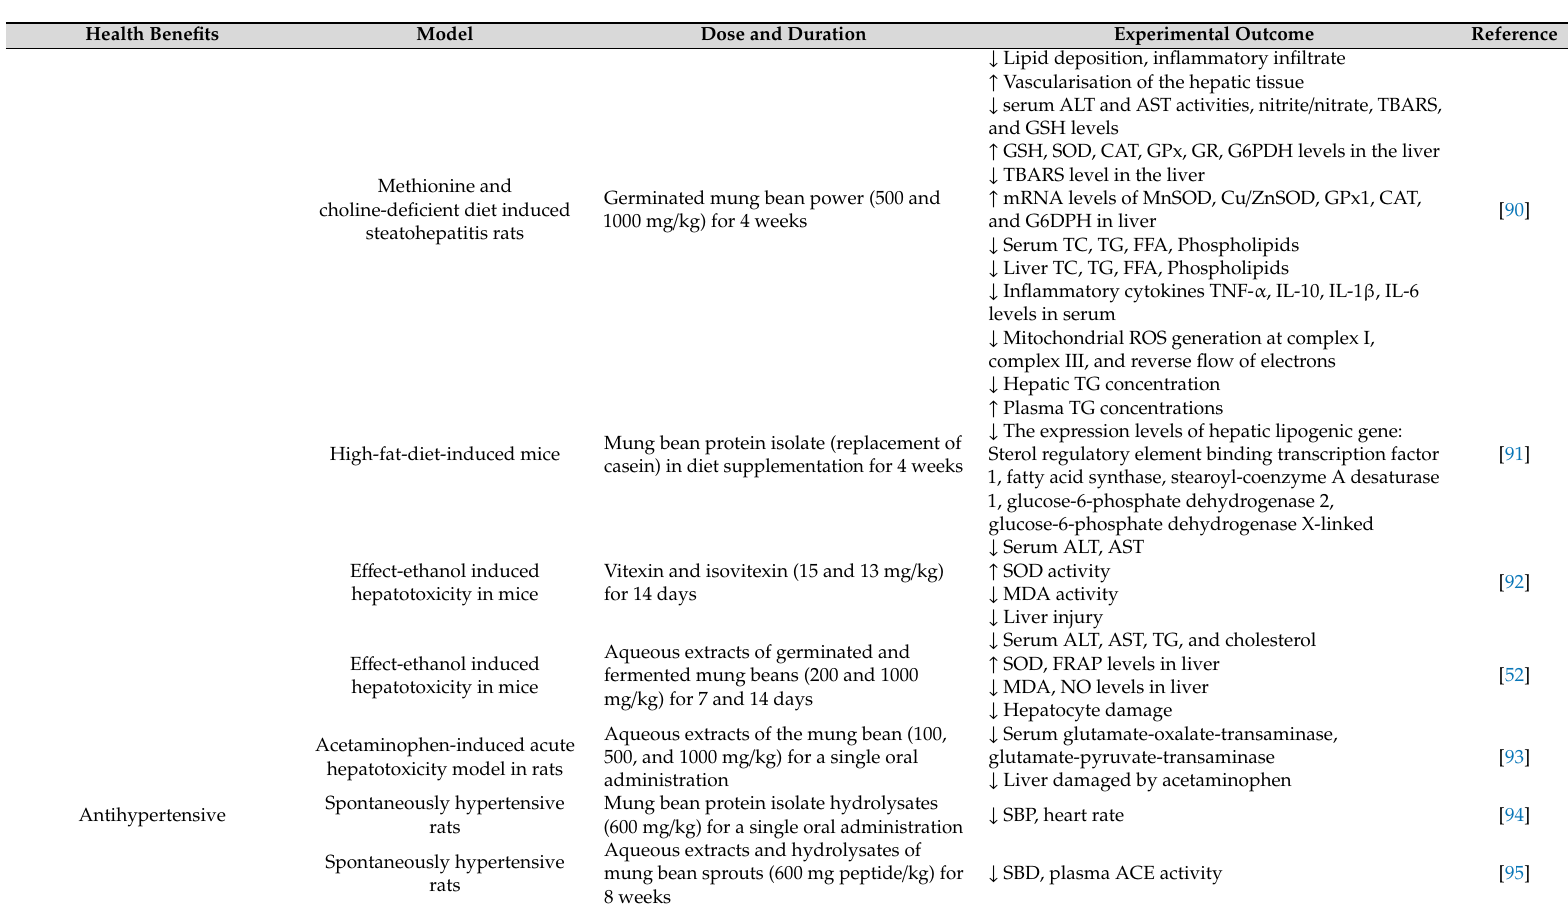
Health Benefits Model Dose and Duration Experimental Outcome Reference